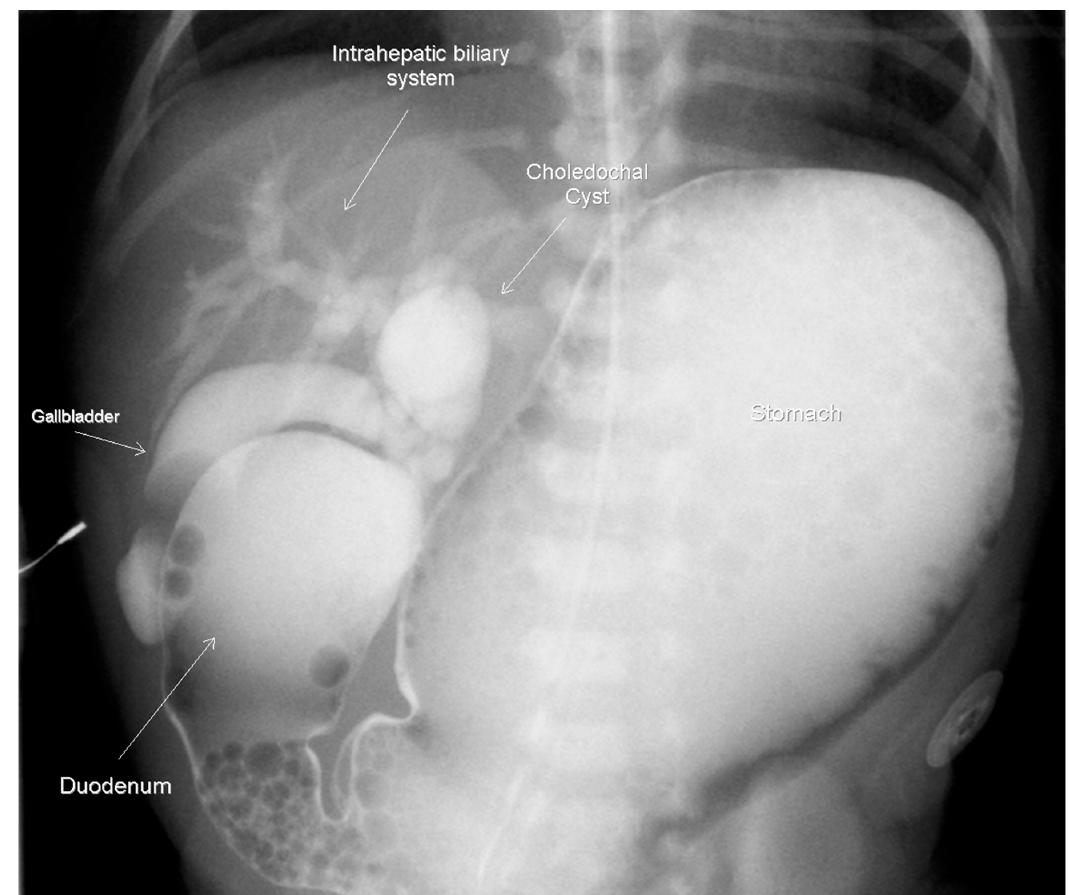
Figure 2. Upper GI contrast study on day-of-life 2, demonstrating the duodenal obstruction with reflux into the dilated biliary tree and a choledochal cyst approximately 14 × 10 mm. At two years of age the patient presented to the emergency department with feeding intolerance, persistent emesis, elevated liver transaminases (AST 244, ALT 288), elevated amylase > 1446 U / L and lipase 465 IU / L. Magnetic resonance imaging (MRI) revealed significantly dilated intra- and extra-hepatic ducts, a distended gallbladder and a large choledochal cyst. The physical exam was significant for ascites and jaundice. She underwent an urgent laparotomy, which found bilious